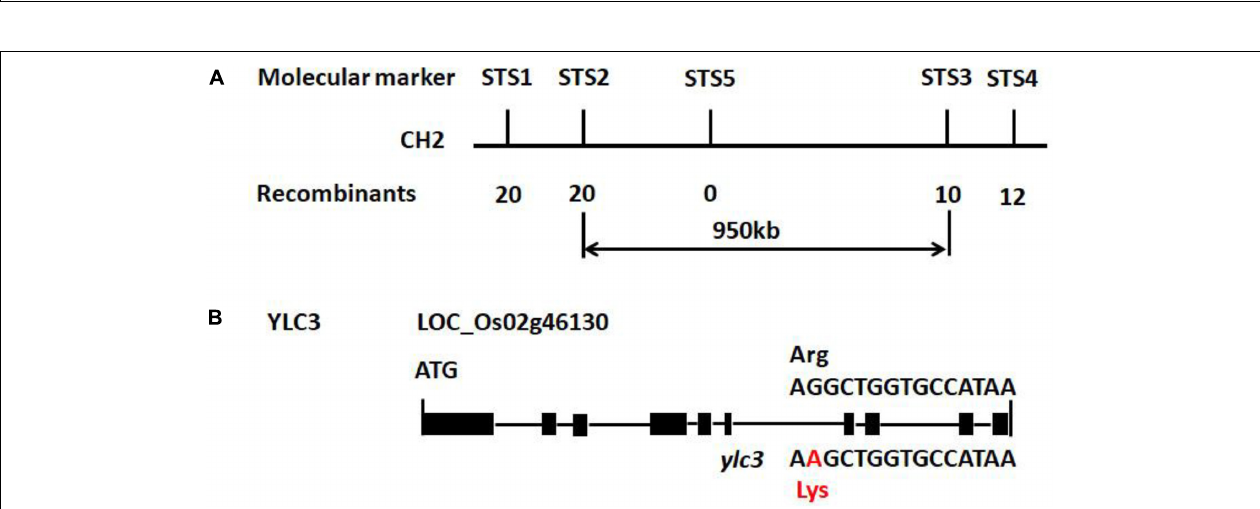
FIGURE 2 | Impaired thylakoid development in ylc3 mutant. (A) WT chloroplasts showed well-developed thylakoids. (B) ylc3 chloroplasts showed reduced number of thylakoid grana lamella.